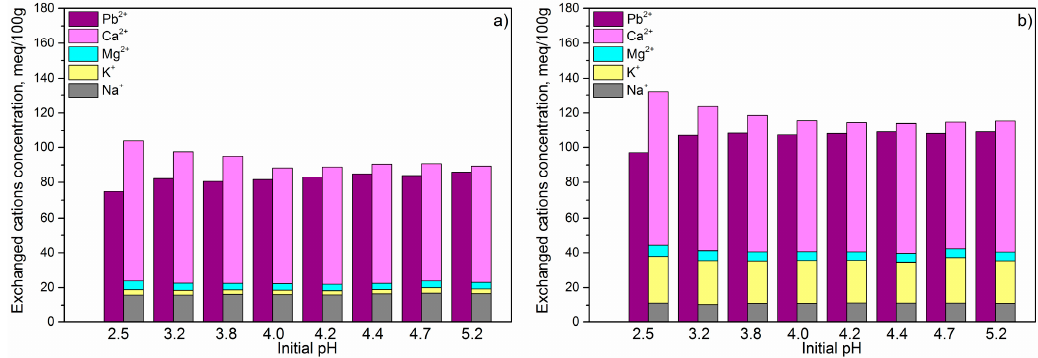
Figure 8. The amounts of Pb 2+ adsorbed and cations released for different pH i . ( a ) NZA; and, ( b ) FeA.